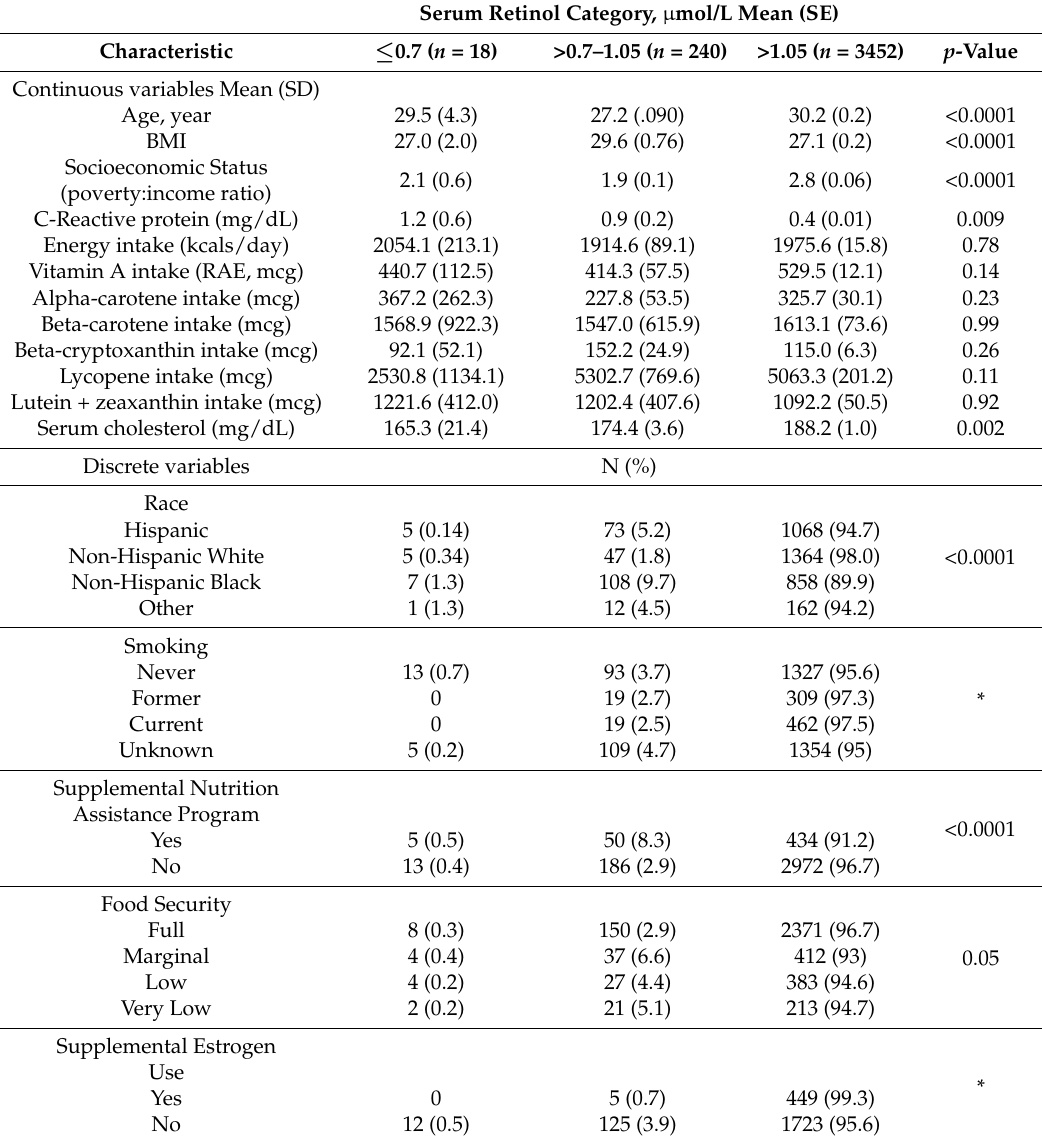
Table 1. Participant characteristics by serum retinol